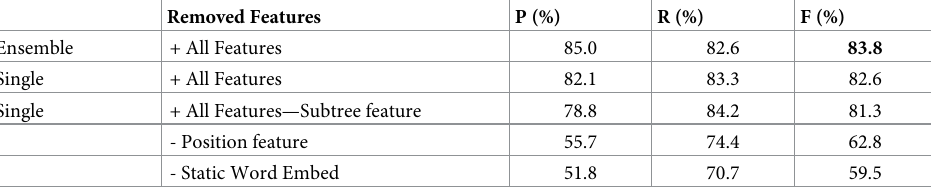
Table 10. Performance changes of our model on the PK DDI in vivo dataset by removing features.